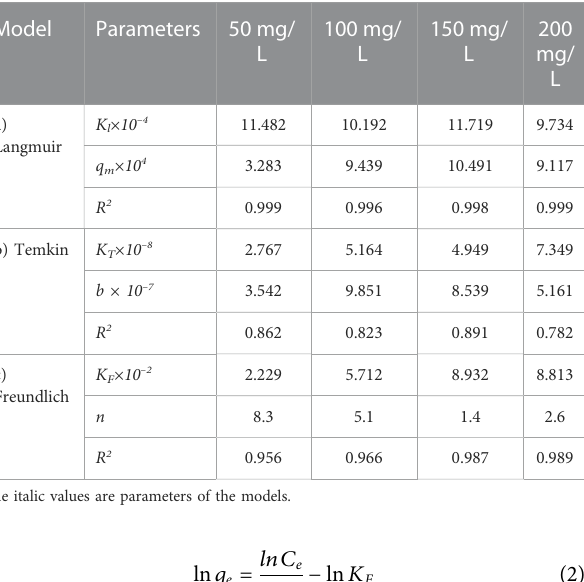
TABLE 12 Parameters of a) Langmuir, b) Temkin, and c) Freundlich isotherm models at different adsorbent amount using Oil sludge 1 as carbon active at T = 318 K and pH =